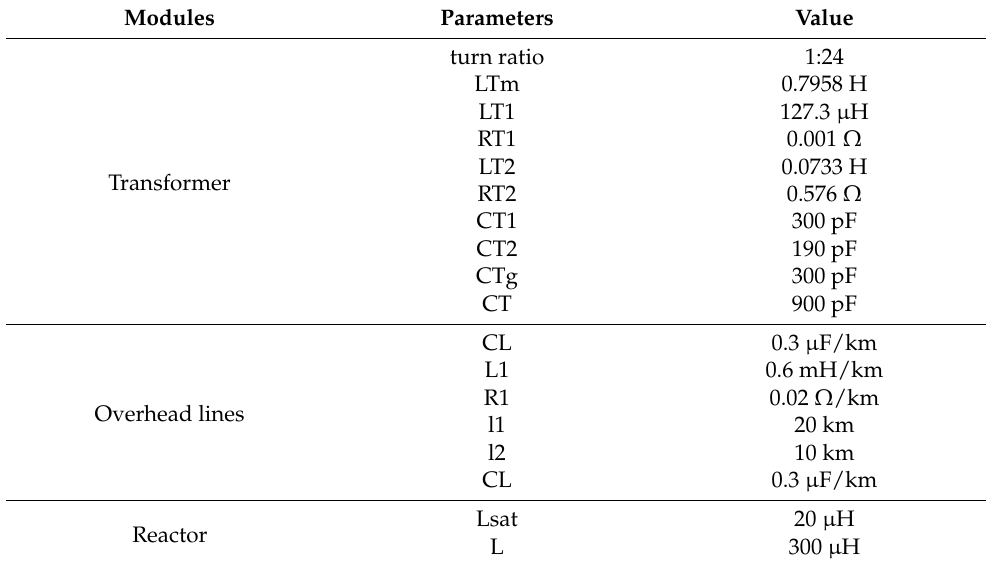
Table 1. Parameters of high-voltage rectifier.